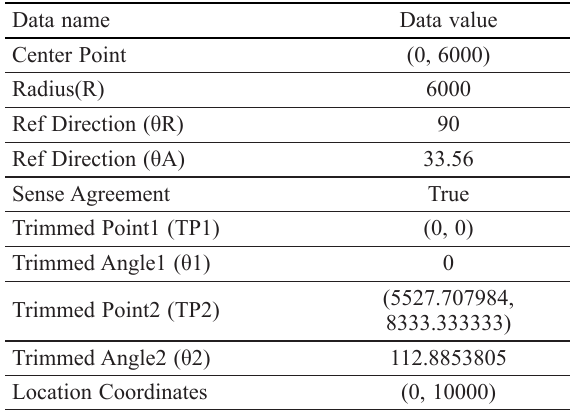
Table 2. Data extracted from model